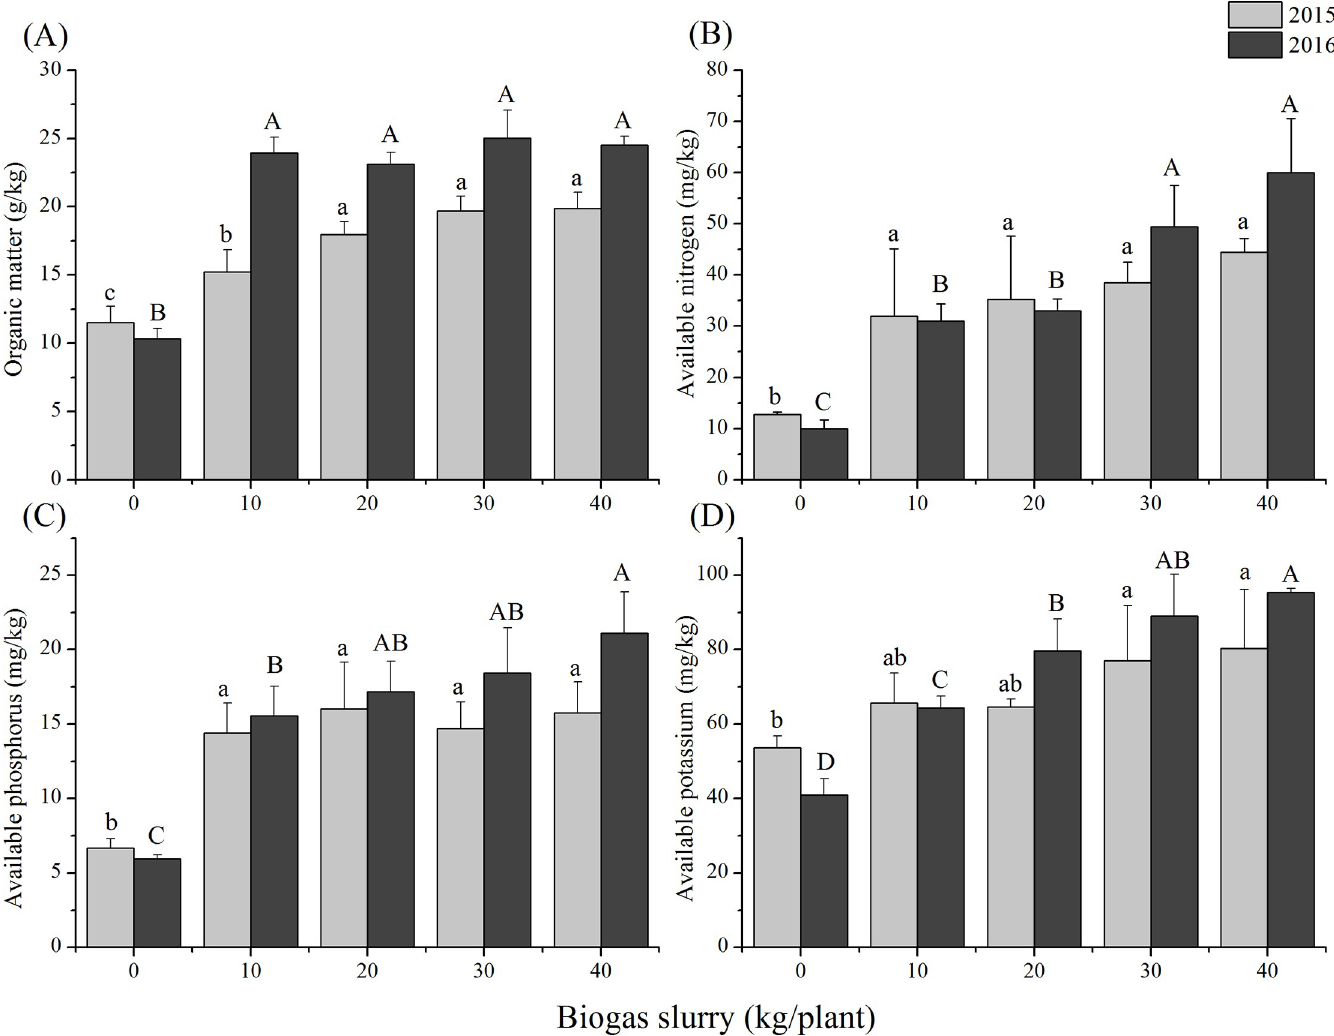
Fig 1. Effects of biogas slurry on contents of (A) organic matter, (B) available nitrogen, (C) phosphorus and (D) potassium in rhizosphere soil during 2015 and 2016. Different small and capital letters indicate the significant differences among five levels of biogas slurry addition in 2015 and 2016, respectively (p <